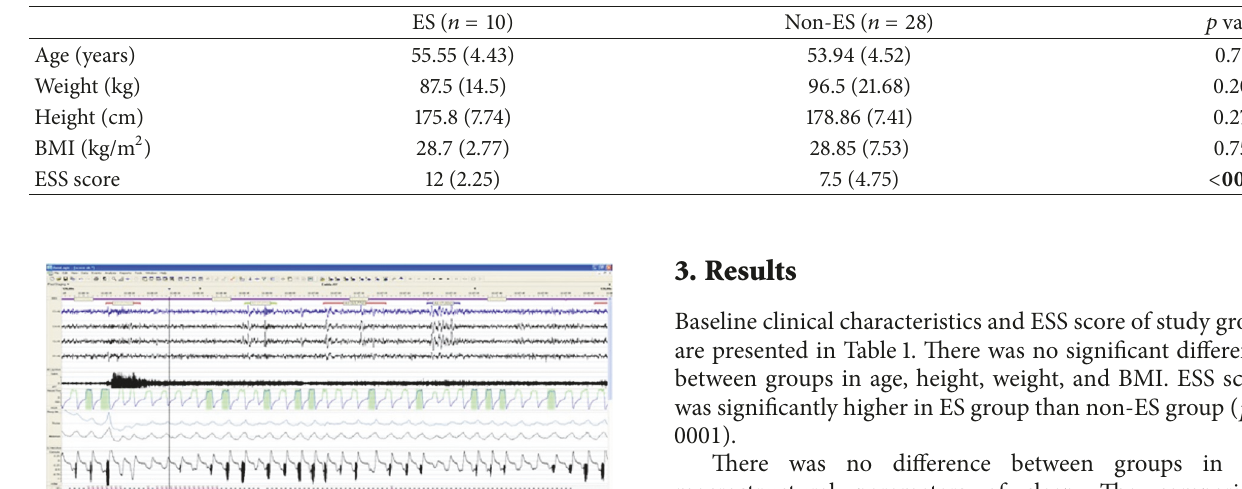
Table 1: Comparison of clinical characteristics and ESS score in OSA patients with and without ES (ES versus non-ES).